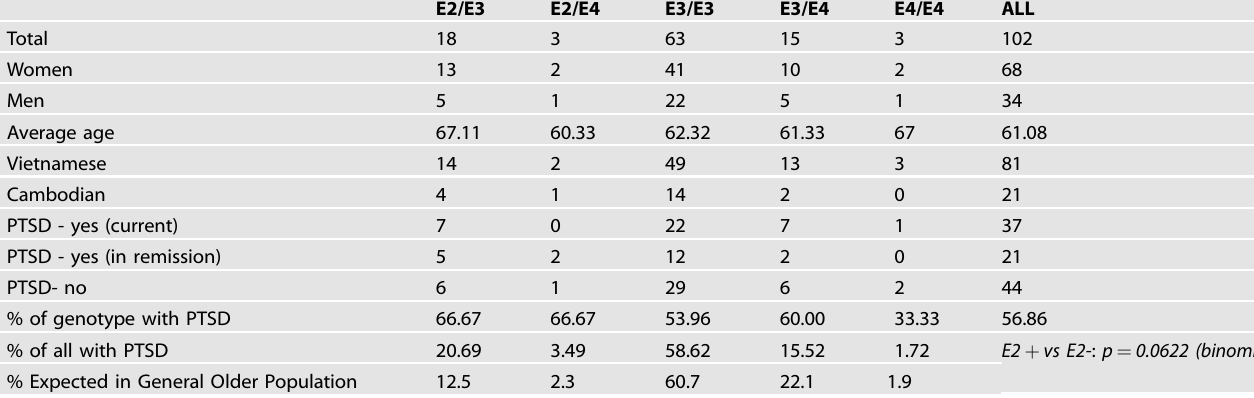
Table 1. APOE genotype frequencies and PTSD diagnosis status in Vietnamese and Cambodian patients at the OHSU